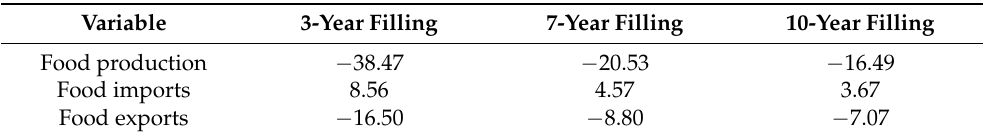
Model 3 : For agricultural sector employment variables (with a shorter time span